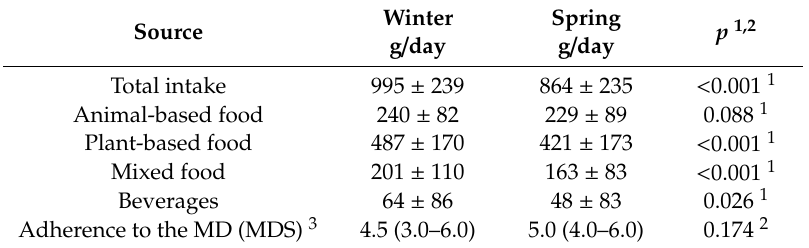
Table 1. Daily intakes of main food sources and adherence to the Mediterranean diet (MD) by seasons.